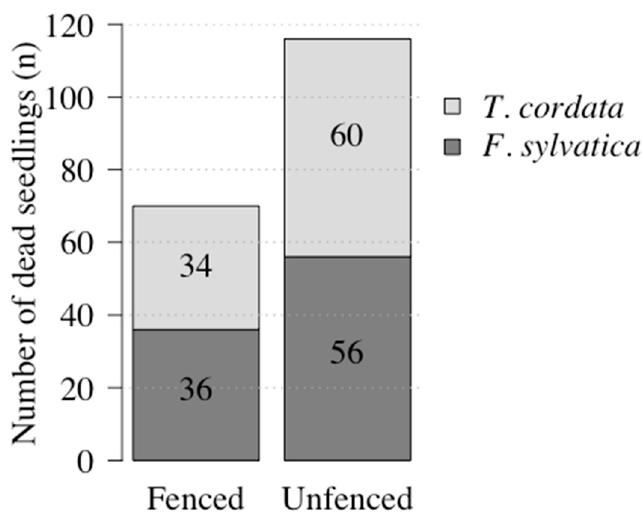
Figure 1. Absolute number of dead Fagus sylvatica and Tilia cordata seedlings on fenced and unfenced plots after the growing season 2017 in the whole experiment.